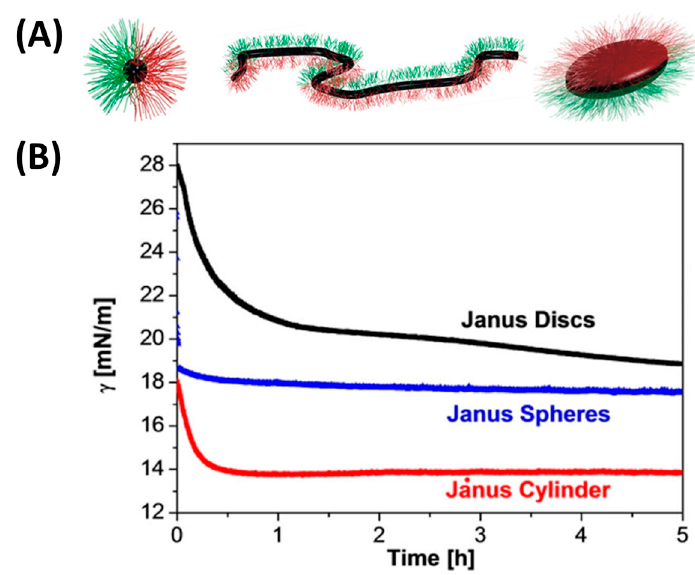
Figure 18. ( A ) Overview of possible Janus particle architectures: Spheres, Cylinders, and Discs; ( B ) Influence of the Janus particle shape on the interfacial tension. Interfacial tension isotherms of solutions of Janus particles in toluene at a water/toluene interface. Adapted with permission from [141]. Copyright 2013, American Chemical Society.